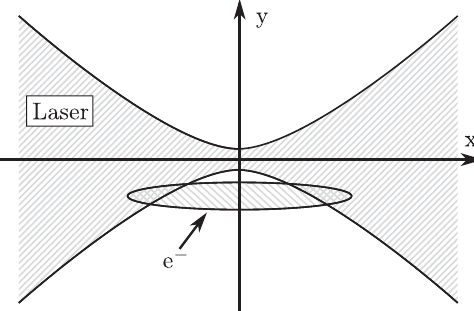
FIG. 5. Schematic of the laser focus showing its interaction with the high aspect ratio electron beam even when the laser focus is displaced from the electron beam. The vertical axis is expanded in scale compared to the horizontal axis to make the overlap